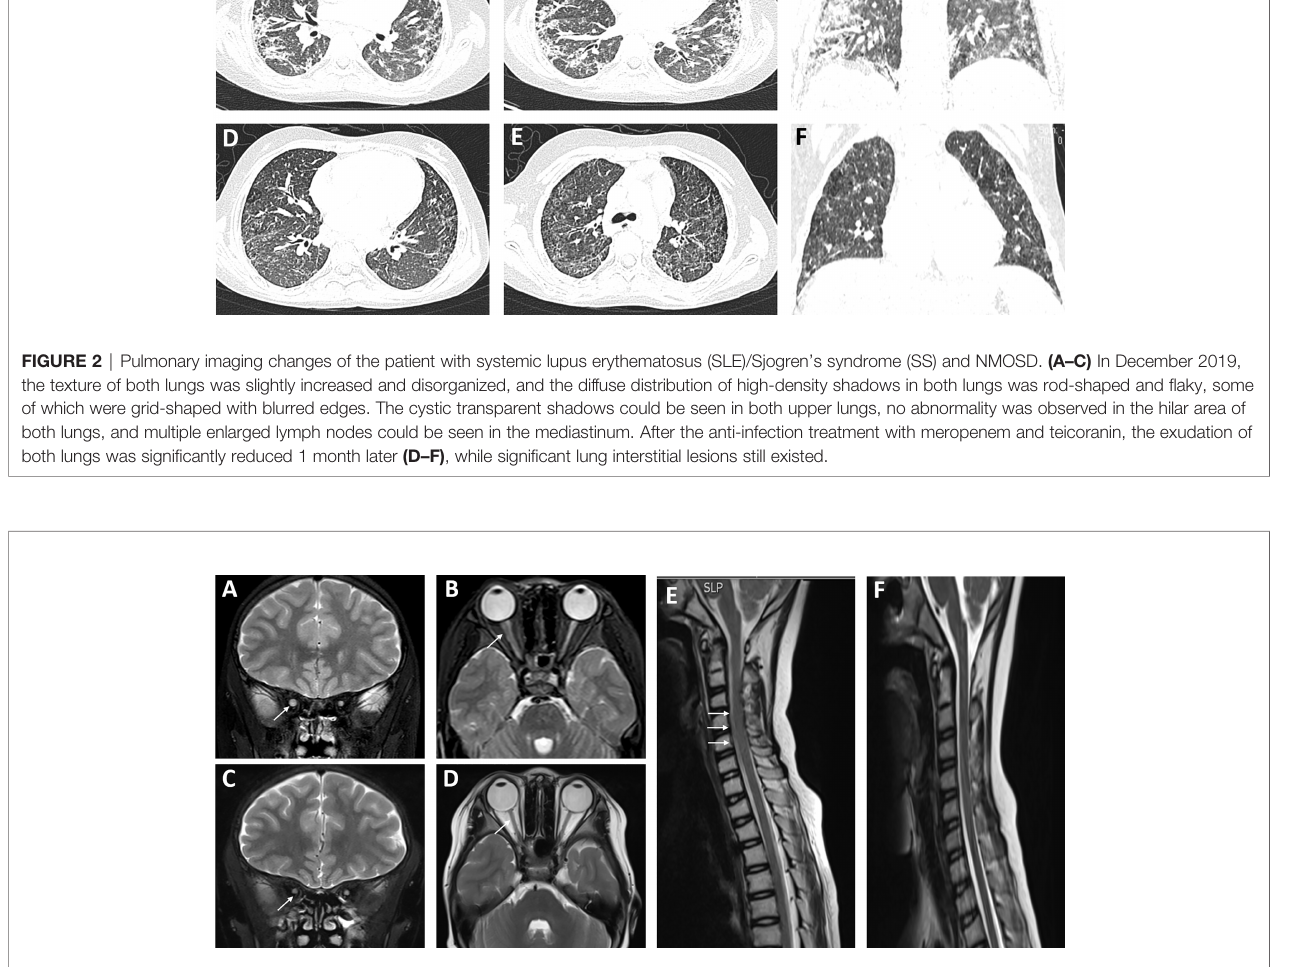
FIGURE 3 | Neuroimaging changes of the patient with systemic lupus erythematosus (SLE)/Sjogren ’ s syndrome (SS) and NMOSD. (A, B) The left optic nerve was obviously smaller than the right through MRI, and there was slight swelling of the spinal cord at the levels of c2-6 (E) in December 2018 (shown by arrows). After a powerful immunosuppressive therapy, the left optic nerve was roughly the same size as the right optic nerve in October 2019 (C, D) , and the swelling of c2-6 was much better than before (F) .